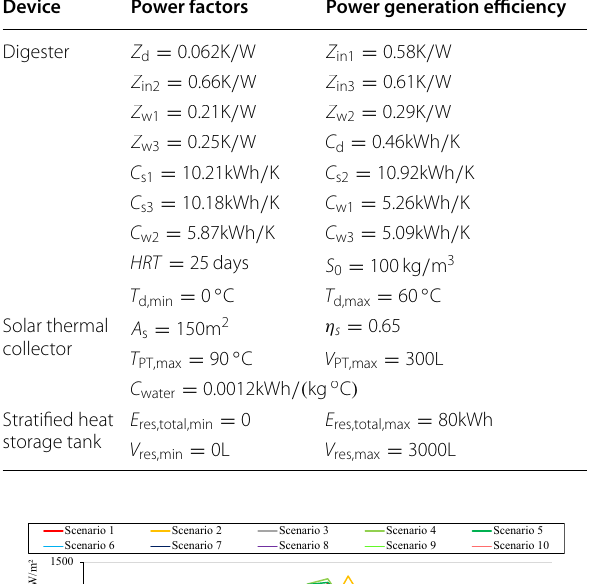
Table 1 Technical specifications of the solar-boosted biogas generation system [5, 23]